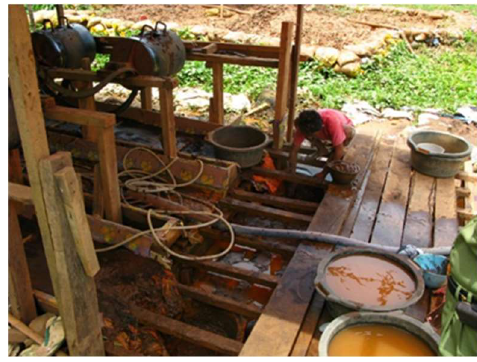
Figure 6. Gold processing sites.